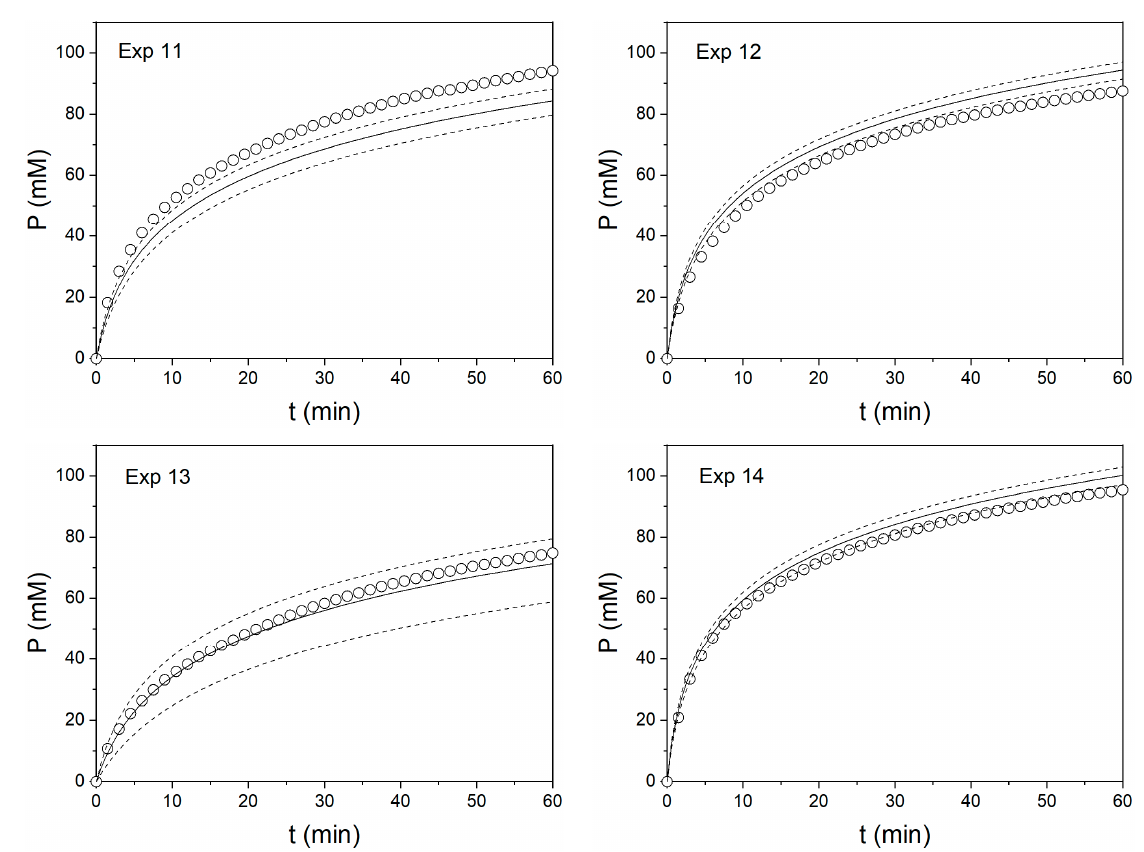
Figure 5. Predicted and experimental hydrolysis curves for the hydrolysis of milk proteins with Protamex. Experimental data (circles), predicted curve (continuous line) and confidence interval of predicted curves at 95% probability (dashed lines) for experiments presented in Table 6.